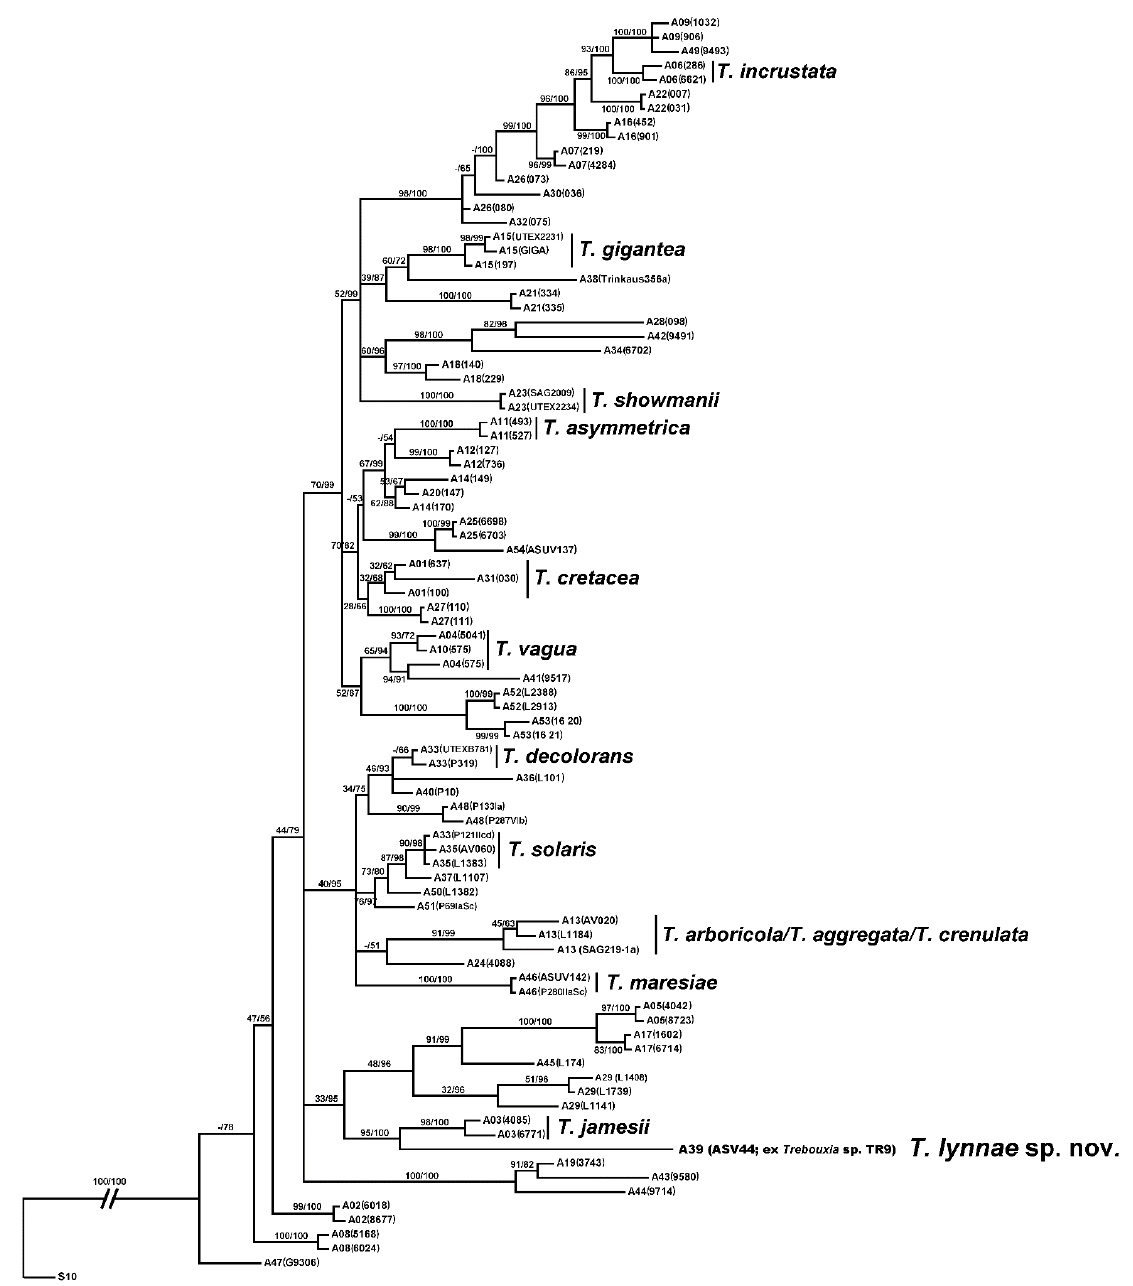
Figure 4. The phylogenetic tree of Trebouxia clade A. Rooted tree based on the concatenated ITS, cox2 and rbcL dataset representing 55 Trebouxia species-level lineages including sequences (retrieved from the GenBank) of 12 formally described Trebouxia species stored at the algal collections SAG and UTEX. Trebouxia lynnae sp. nov. is highlighted. Values at nodes indicate statistical ML bootstrap supports and Bayesian posterior probabilities (BS/PP). Scale bar shows the estimated number of substitutions per